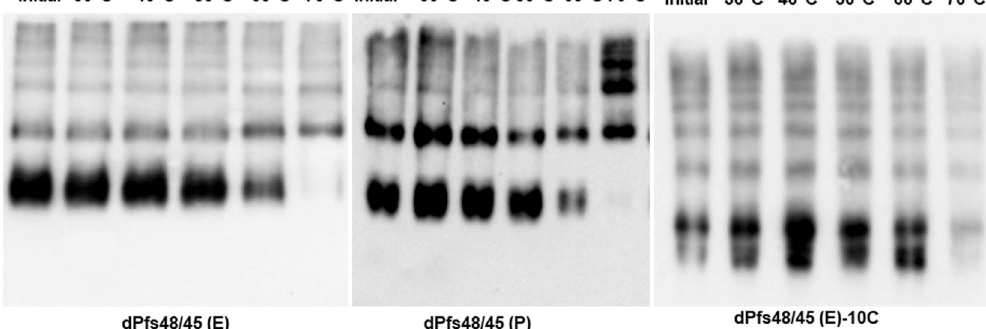
Figure 6. Effect of temperature on the recognition of deglycosylated Pfs48/45 proteins with conformational specific Pfs48/45 monoclonal antibody. Deglycosylated dPfs48/45 (E), dPfs48/45 (P) and dPfs48/45 (E)-10C proteins, as indicated, were incubated at different temperatures as indicated for 15 min and then proteins were run on Native PAGE followed western blotting. Proteins on the membrane were detected using a